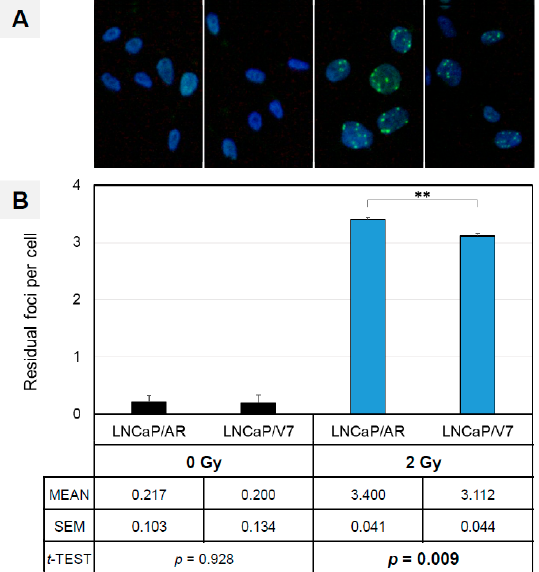
Figure 8. ( A ) The presence of AR-V7 enhances DNA repair in vitro. Increased DNA repair is visualized by a diminished number of residual γ H2Ax foci 24 h after irradiation. Nuclear counterstain with DAPI from left to right: LNCaP/AR (0 Gy), LNCaP/V7 (0 Gy), LNCaP/AR (2 Gy), LNCaP/V7 (2 Gy). ( B ) Quantification of residual γ H2A.X foci 24 h after irradiation (2 Gy, blue). Non-irradiated cells were used for comparison (0 Gy, black). In total, >200 nuclei were counted per cell line, irradiative condition and experiment, with a mean of three independent experiments. ** = p <